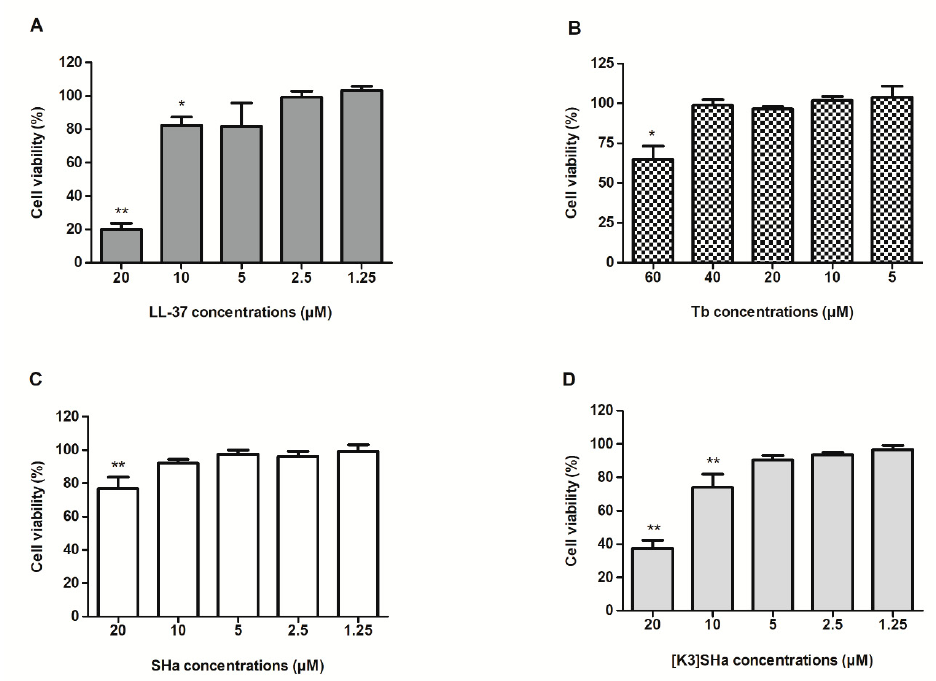
Figure 1. Cytotoxicity of LL-37 and temporins to human primary keratinocytes. Cell proliferation kit II (XTT) assays were performed to assess human primary keratinocytes viability after 24 h of treatment with LL-37 (A), temporin-Tb (Tb) (B), SHa (C) and [K 3 ]SHa (D). Data are represented as mean + standard error of mean (SEM) of at least four independent experiments. * p < 0.05 and ** p < 0.01 compared with the untreated control.